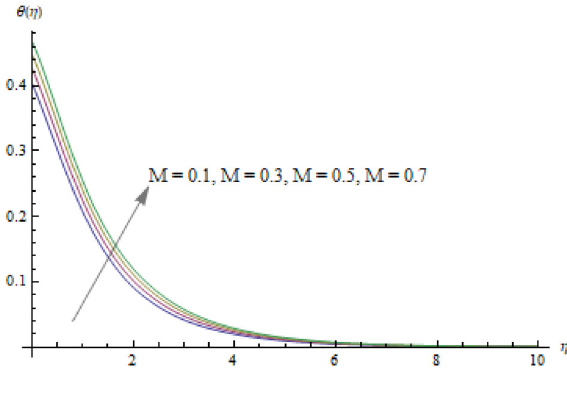
Fig. 10 Impact of M on θ(η)